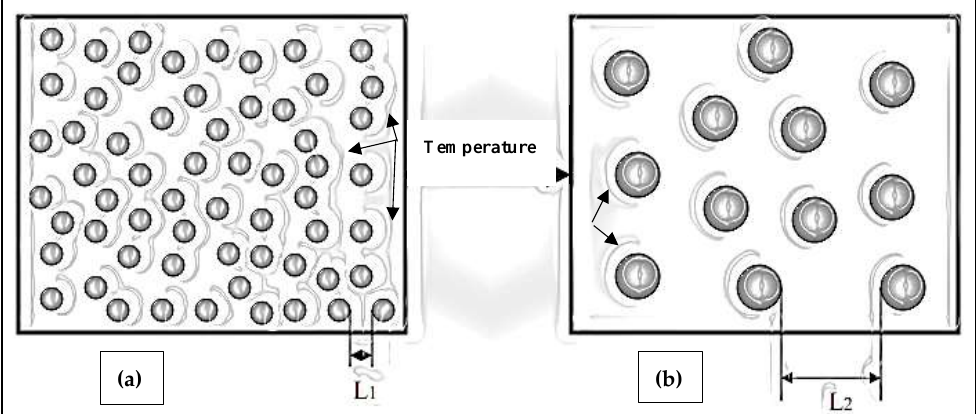
Figure 6. Schematic representation showing the influence of increasing the aging temperature on the size, density, and inter-particle spacing of the hardening precipitates: ( a ) at a low aging temperature and ( b ) at a high aging temperature. (L1 and L2 indicate the inter-particle spacing in each case.). The black arrows represent the dislocations motion through the precipitates.